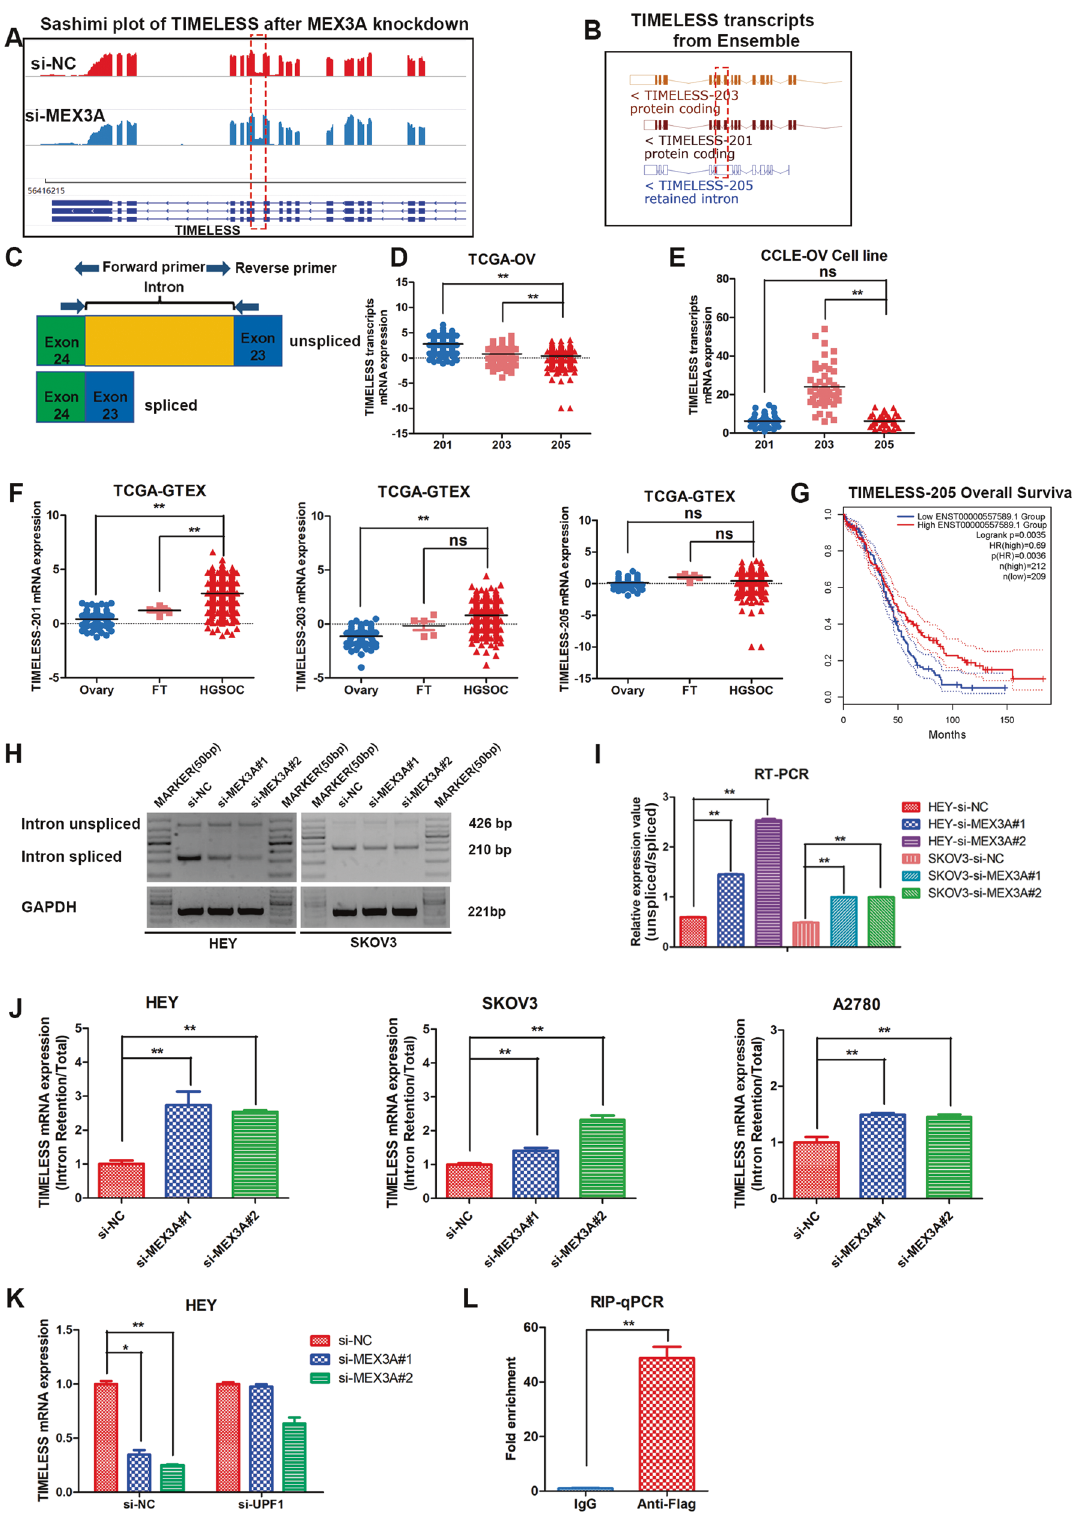
TIMELESS was identi fi ed as a key downstream target of